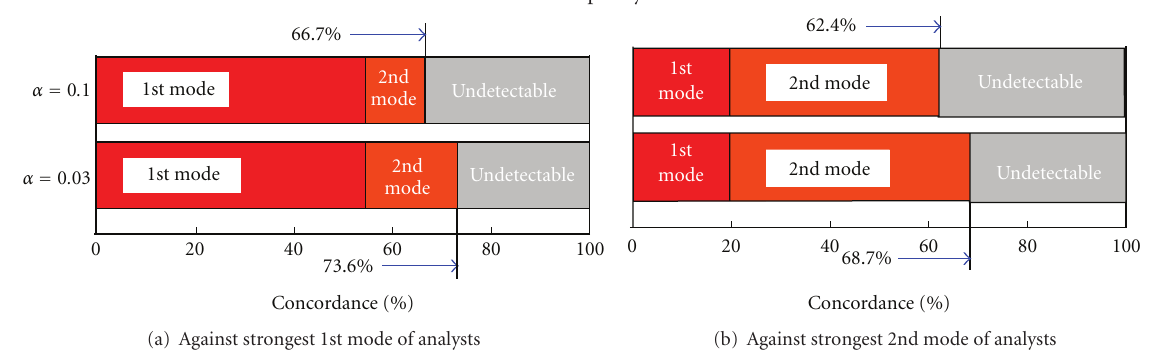
Figure 18: Concordance of identified intentions to human-discriminated ones when multiple di ff erent intentions are considered.